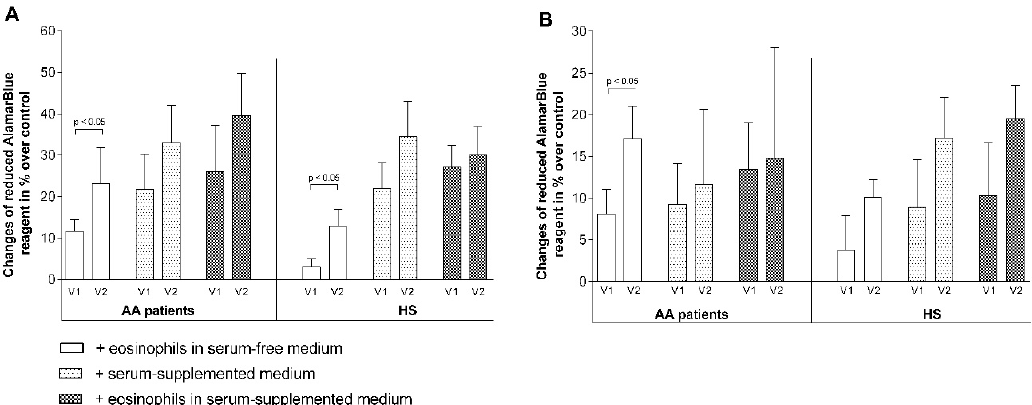
Figure 10. Bronchial allergen challenge effect on pulmonary structural cell proliferation. ( A ) The effect of a bronchial allergen challenge on eosinophil-promoted ASM cell proliferation; ( B ) the effect of a bronchial allergen challenge on eosinophil-promoted pulmonary fibroblast proliferation. Results from independent experiments of AA— n = 11, HS— n = 11; V1—Visit 1 (before the bronchial allergen challenge); V2—Visit 2 (24 h after the bronchial allergen challenge). Statistical analysis: between investigated groups—Mann–Whitney two-sided U-test; within one study group—Wilcoxon matched-pairs signed-rank two-sided test.